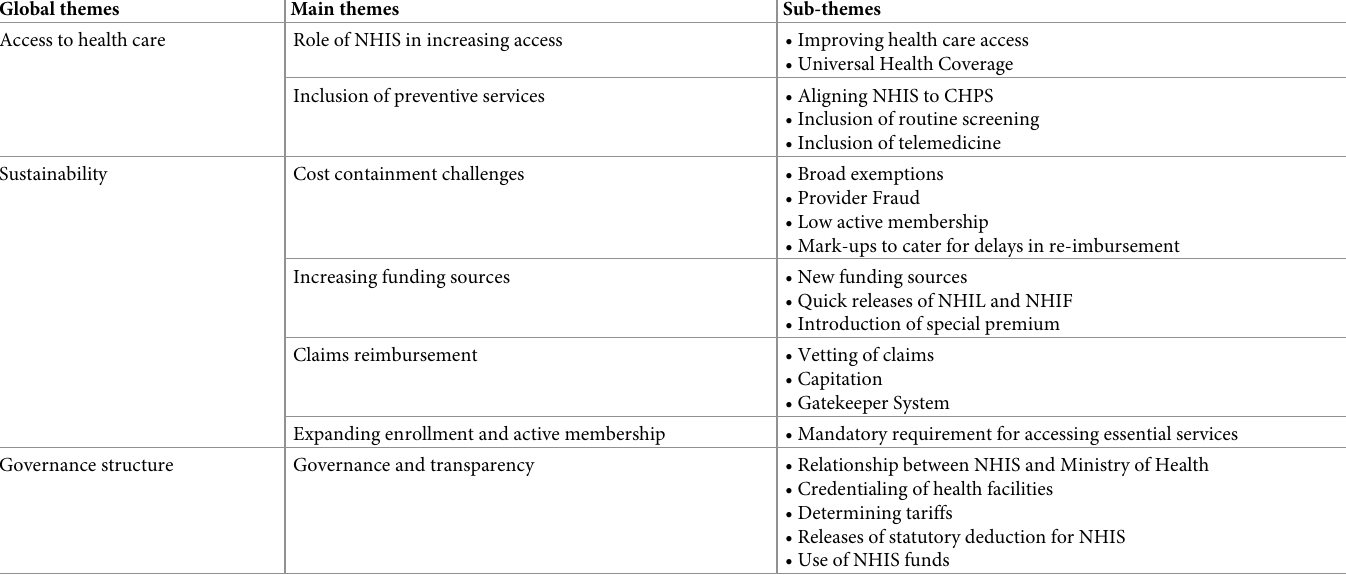
Table 1. Themes that emerged from the